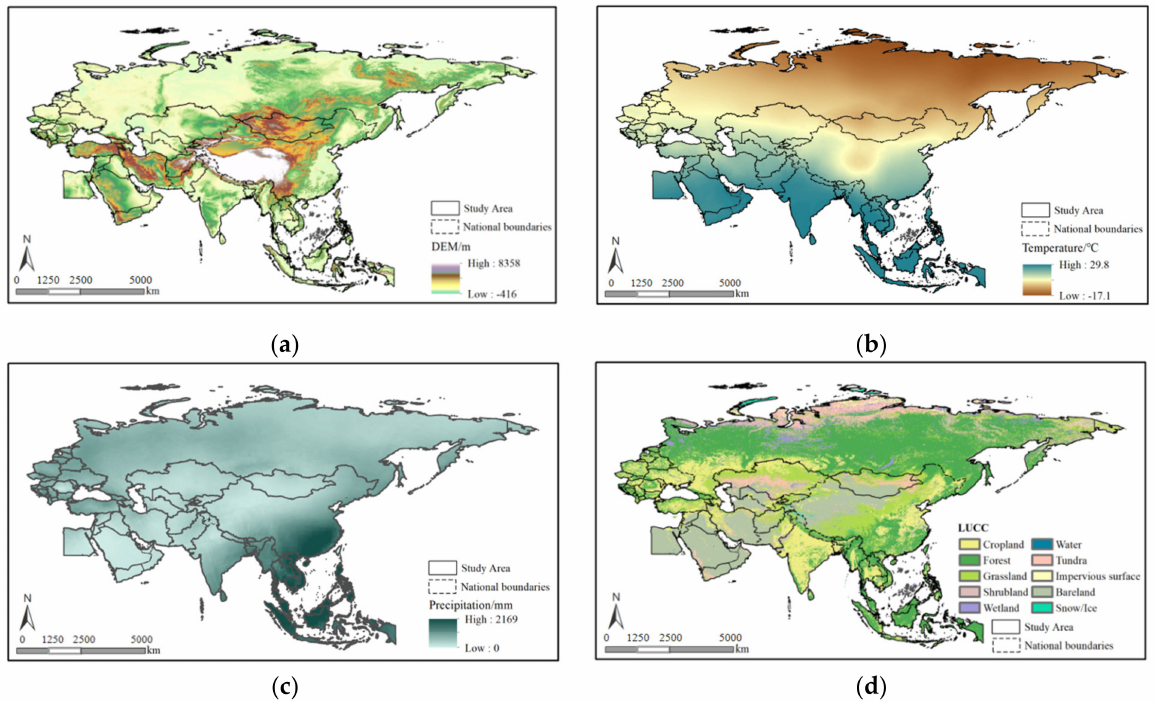
Figure 1. General details of the BRI area. Note: ( a ) the DEM of the BRI, ( b ) the mean annual temperature of the BRI, ( c ) the LSWI of the BRI, and ( d ) the LUCC of the BRI. There are complex and variable climate conditions in the BRI, with an extremely un- even temperature distribution pattern from South Asia to Central and Eastern Europe